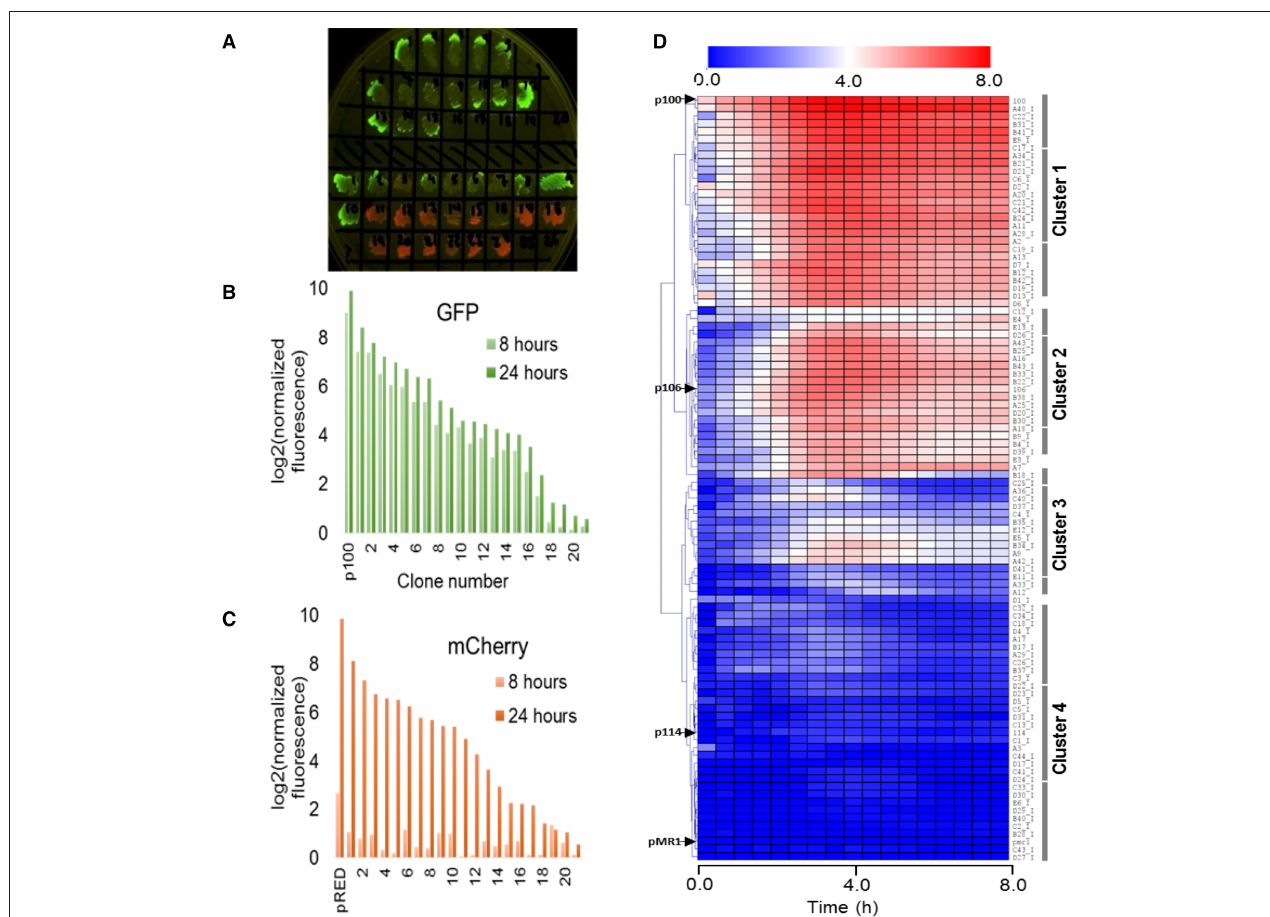
FIGURE 2 | Evaluating the expression dynamics of fluorescent clones. (A) LB-agar plate under blue light excitation comprising a subset of metagenomic isolated clones expressing GFPlva (top) and mCherry (bottom) fluorescent reporters. A few clones were observed to express both reporters. All isolated clones were initially considered to hold at least one endogenous promoter. (B,C) Indirect assessment of maturation times from both fluorescent reporters GFPlva (B) and mCherry (C) after 8h (light bars) and 24h (dark bars) of the beginning of the experiment. Maturation times are substantially lower for mCherry than for GFPlva, which excluded the former from further analyses. Positive controls for GFP and mCherry are represented by p100 and pRED, respectively. Fluorescence data has been normalized by OD 600 values for each sample following normalization by values from the negative control (empty-pMR1). Data was transformed to log2 scale to allow better visualization of fluorescence variation. (D) Hierarchical representation of a metaconstitutome (i.e., all expression profiles from a single metagenomic library (USP3) in E. coli . Fluorescence time-lapse dynamics were measured during 8h for each clone and represented as heat maps. Promoter activities (calculated as GFP/OD 600 ) were normalized by the negative control ( E. coli DH10B harboring empty pMR1) and transformed to log2 scale in order to facilitate the visualization of subtle activities. Positive controls (p100, p106, and p114-strong, medium and low expression, respectively) and negative control (pMR1) expression profiles are indicated by black arrows at the left side of the heatmap. Data are representative of three independent